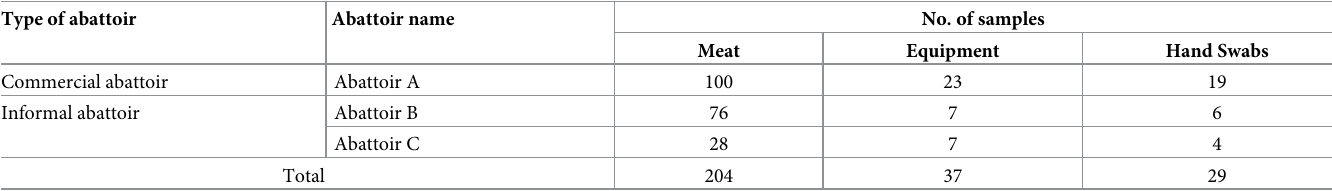
Table 1. Summary of sample numbers from both informal and commercial